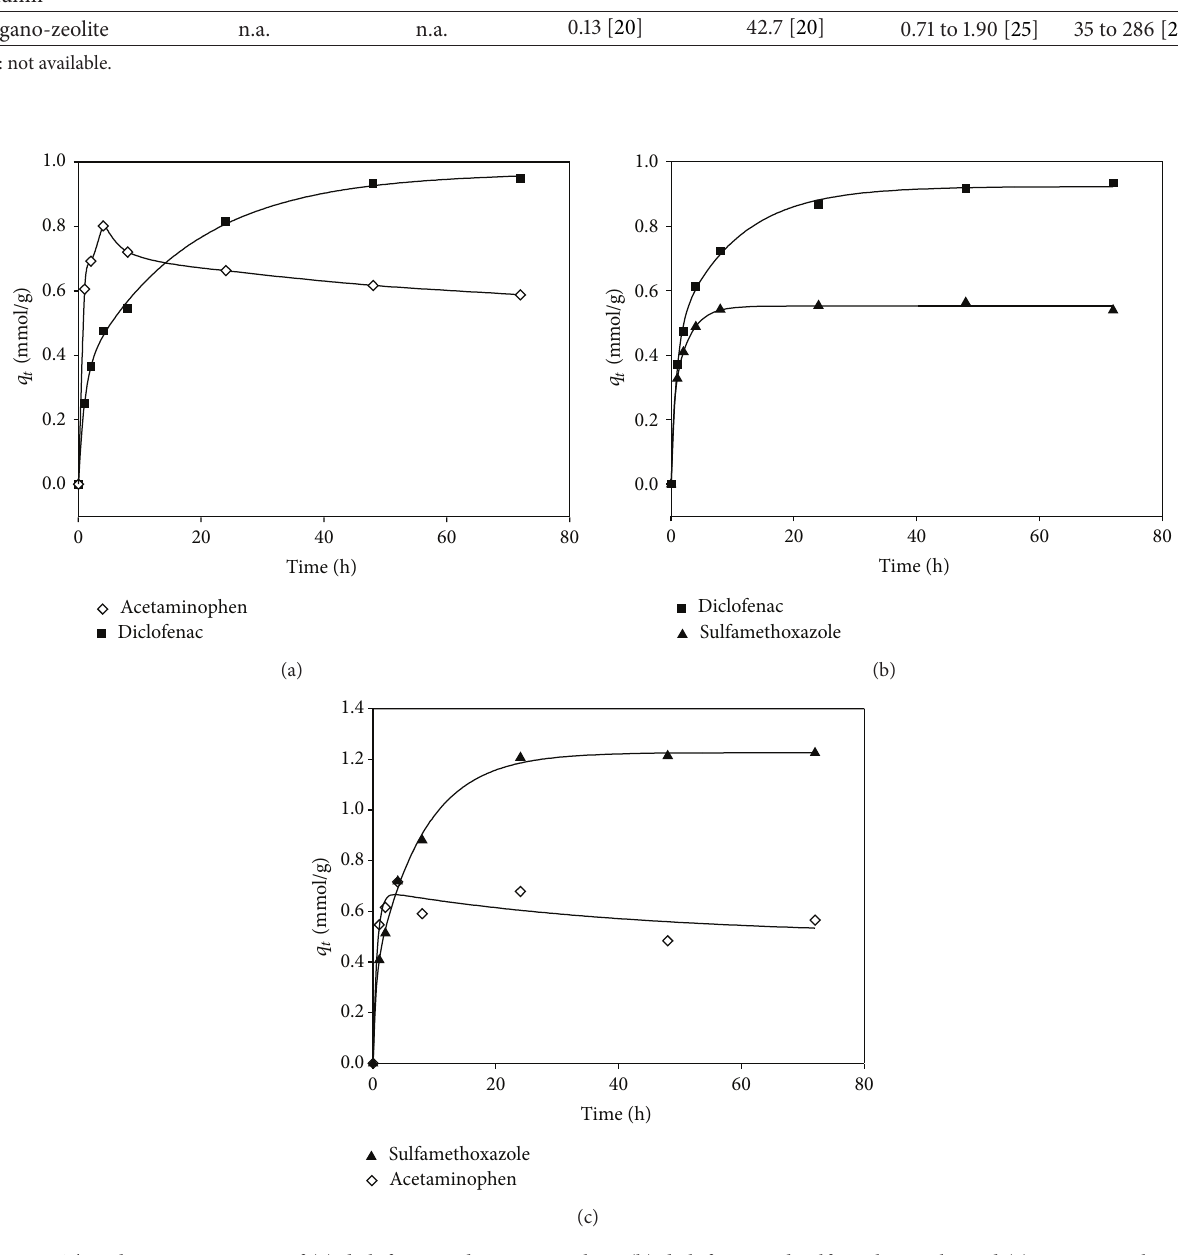
Figure 3: The adsorption capacity of (a) diclofenac and acetaminophen, (b) diclofenac and sulfamethoxazole, and (c) acetaminophen and sulfamethoxazole onto GAC in binary mixture (stirring speed of 140 rpm for 72 h and 25 ∘ C. The initial concentration of each target compound was